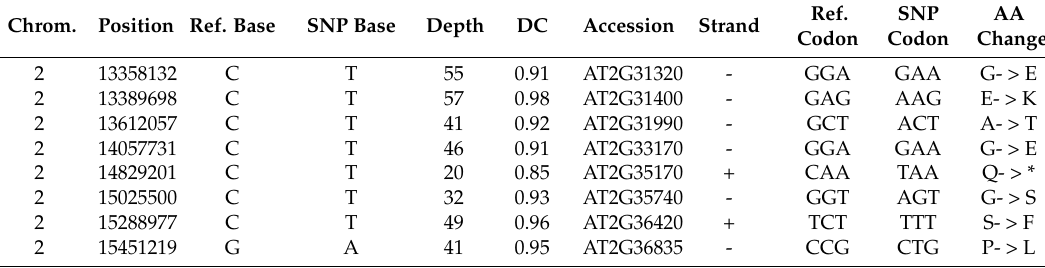
Table 1. Candidate asr2 genes. Shown are predicted EMS-induced mutations in coding regions of genes in the asr2 loci. Reference base refers to the Col-0 reference and SNP base to the detected SNP. DC refers to the discordant chastity